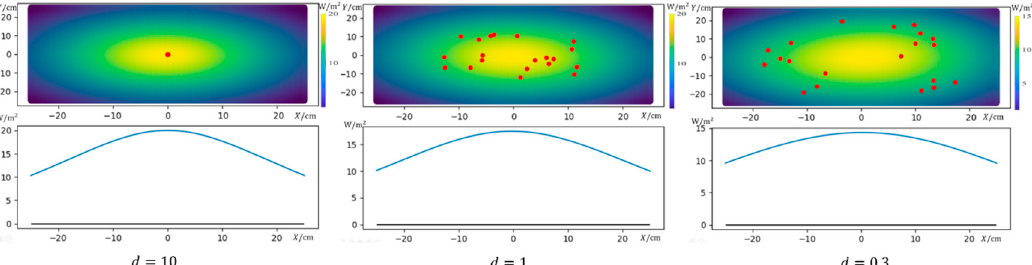
Figure 7. Red LED simulation diagram.